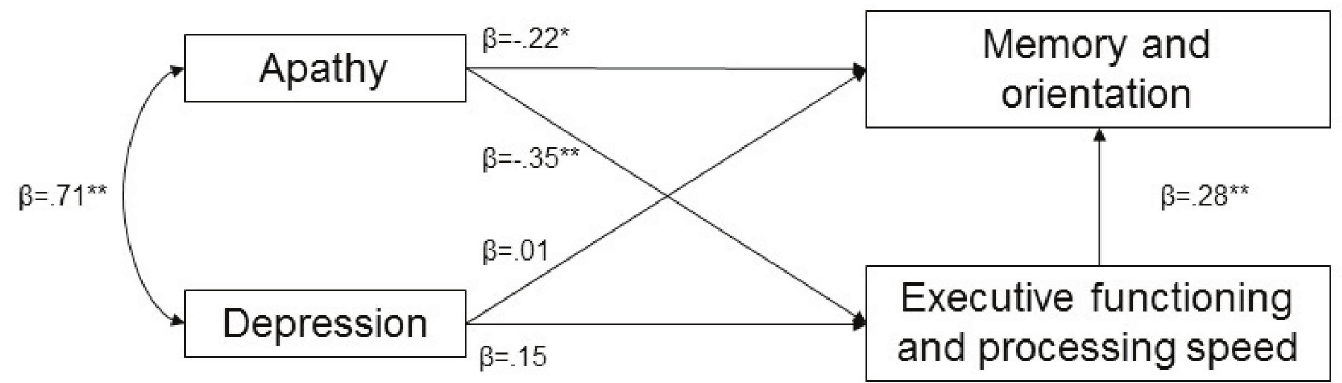
Fig 1. Path analysis model. Path analysismodel showingthat the magnitude of apatheticsymptoms, but not depressivesymptoms, is associated with memory/orientationand executive functioning/ processingspeed. PremorbidIQ and age were both regressedinto the model (not displayed). There was a strong covariancebetweenage and depressivesymptoms ( β = -.30, p < .001), and betweenpremorbidIQ and executive function/processingspeed( β = .35, p < .001) and memory/orientation( β = .16, p = .019). * p < .05; ** p < .005.